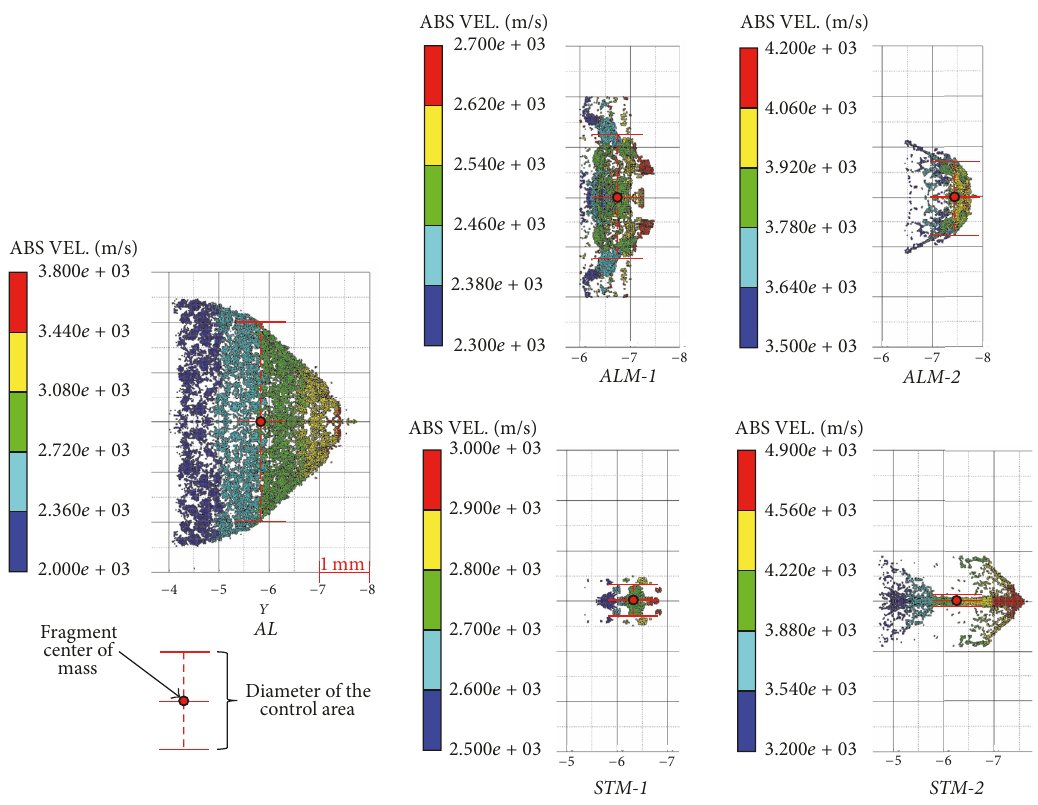
Figure 13: Central fragments of debris clouds.